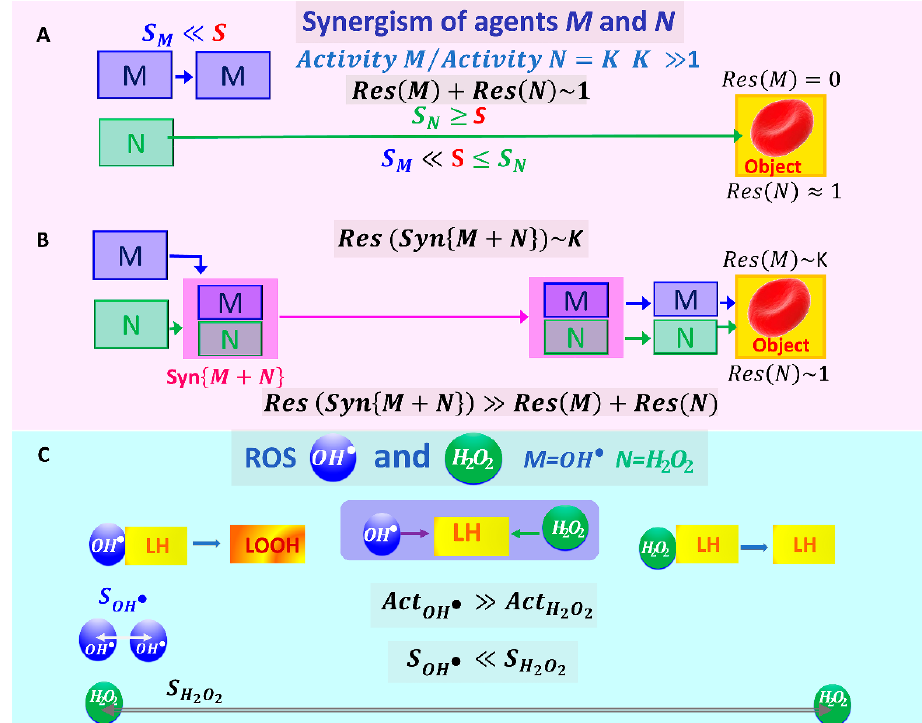
Figure 3. Schematic representation of the mechanochemical synergism effect of two factors 𝑀 and 𝑁 with very different levels of action on the RBC membrane 𝐴𝑐𝑡 (cid:3014) 𝐴𝑐𝑡 (cid:3015) ⁄ = 𝐾 and,